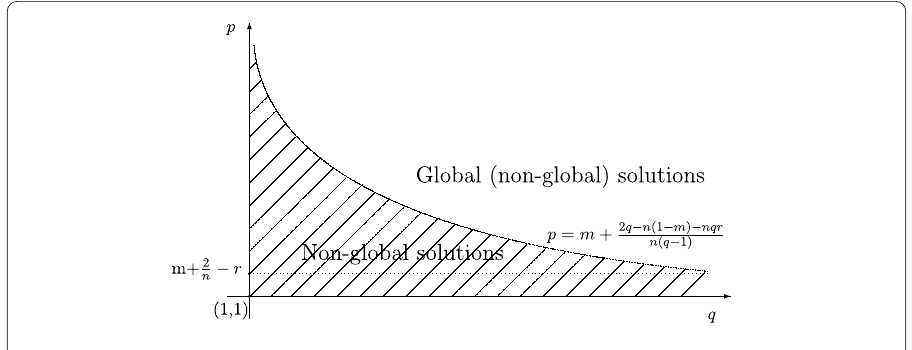
Figure 1 Critical Fujita exponent curve in q – p